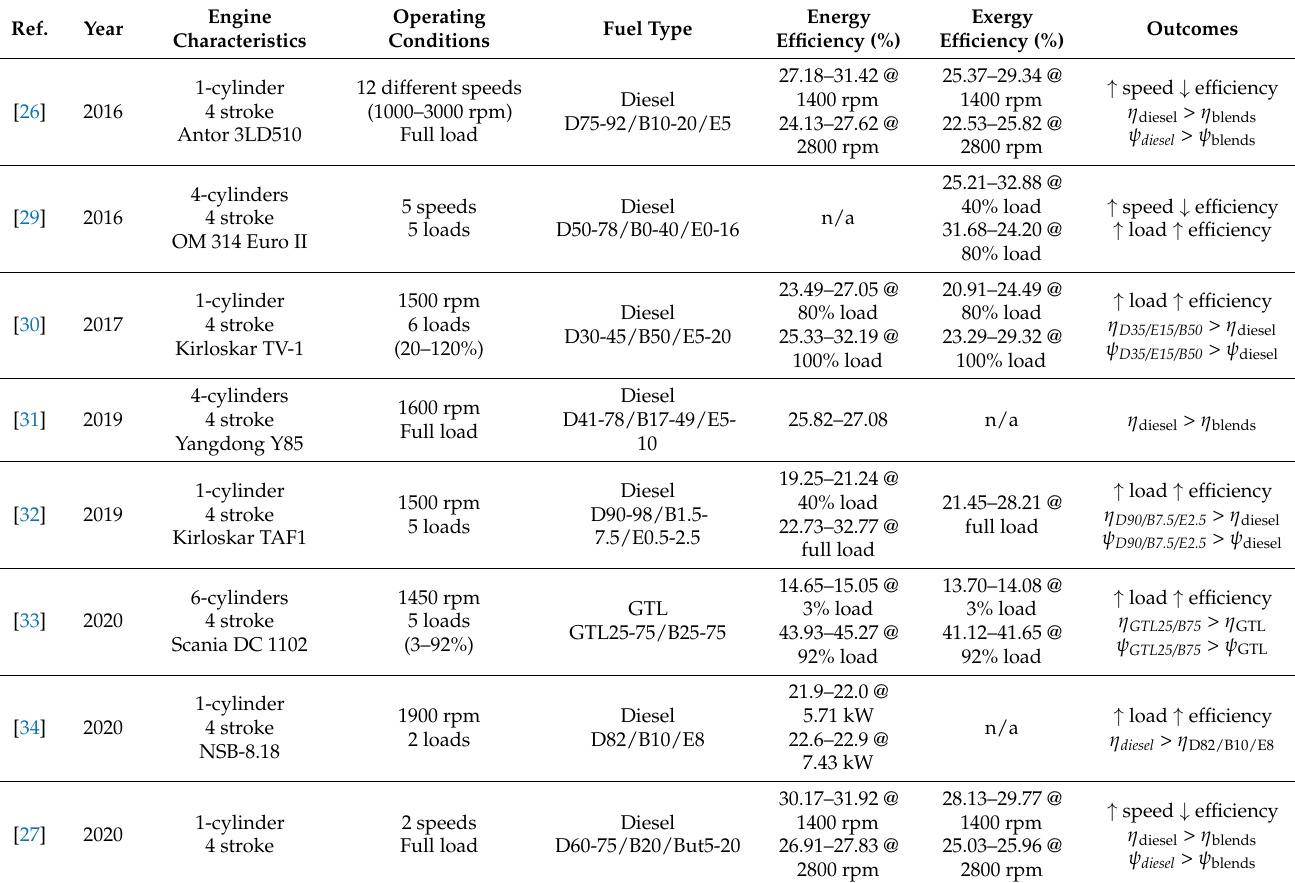
Table 1. Summary of the energy and exergy results from other investigations.